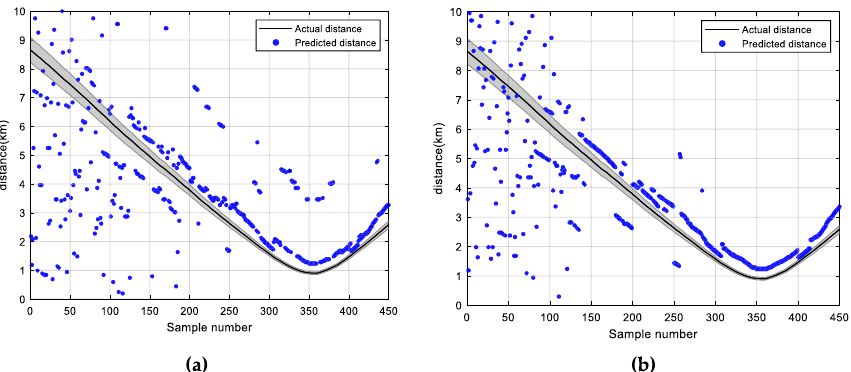
Fig. 7 MFP Processing results: a narrowband {163} Hz matching field results; b {109, 127, 145, 163, 198, 232,